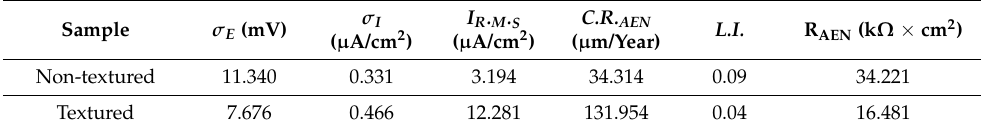
Table 3. AEN factors of the non-textured and textured samples in 0.6 M NaCl for 2